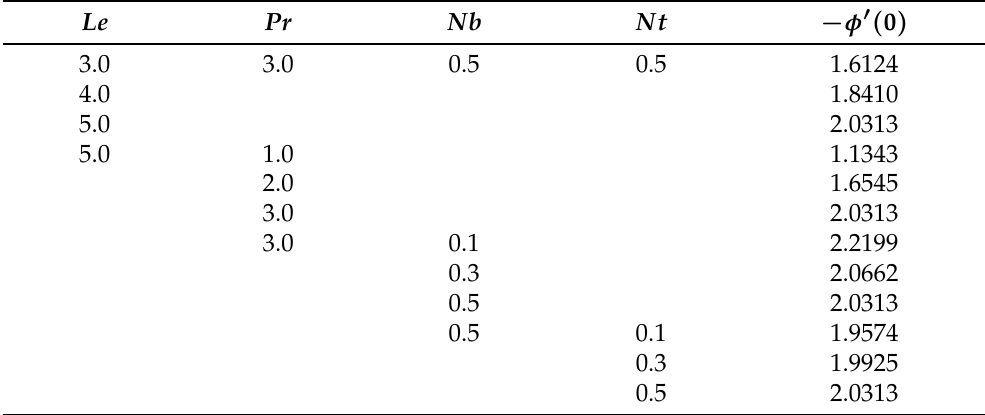
Table 4. Results for − φ (cid:48) ( 0 )